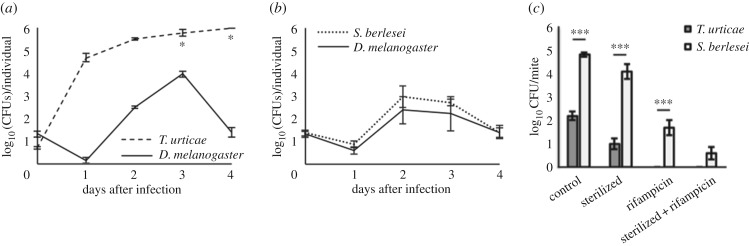
Escherichia coli proliferation in different species correlates with host survival patterns and gut microbiota size. T. urticae, D. melanogaster and S. berlesei were infected with 5–100 CFUs of E. coli per individual and bacterial dynamics within the host was quantified daily for up to 4 days after infection. (a) In T. urticae, an increase in the number of CFUs in living individuals was observed over the course of 2 days. At 3 and 4 days (asterisk), only dead individuals were plated as there were no survivors, but the CFUs did not increase significantly. (b) For S. berlesei injection, the dynamics of E. coli growth was similar to that of D. melanogaster. (c) Gut microbiota is virtually absent in T. urticae as opposed to S. berlesei. Untreated mites (control) or treated with different protocols to remove bacteria from their surface (sterilized), from their gut (rifampicin) and from both their surface and gut (sterilized and rifampicin) were homogenized and plated on a Petri dish containing LB agar. T. urticae is colonized by two to three orders of magnitude less bacteria than S. berlesei. ***p < 0.001.